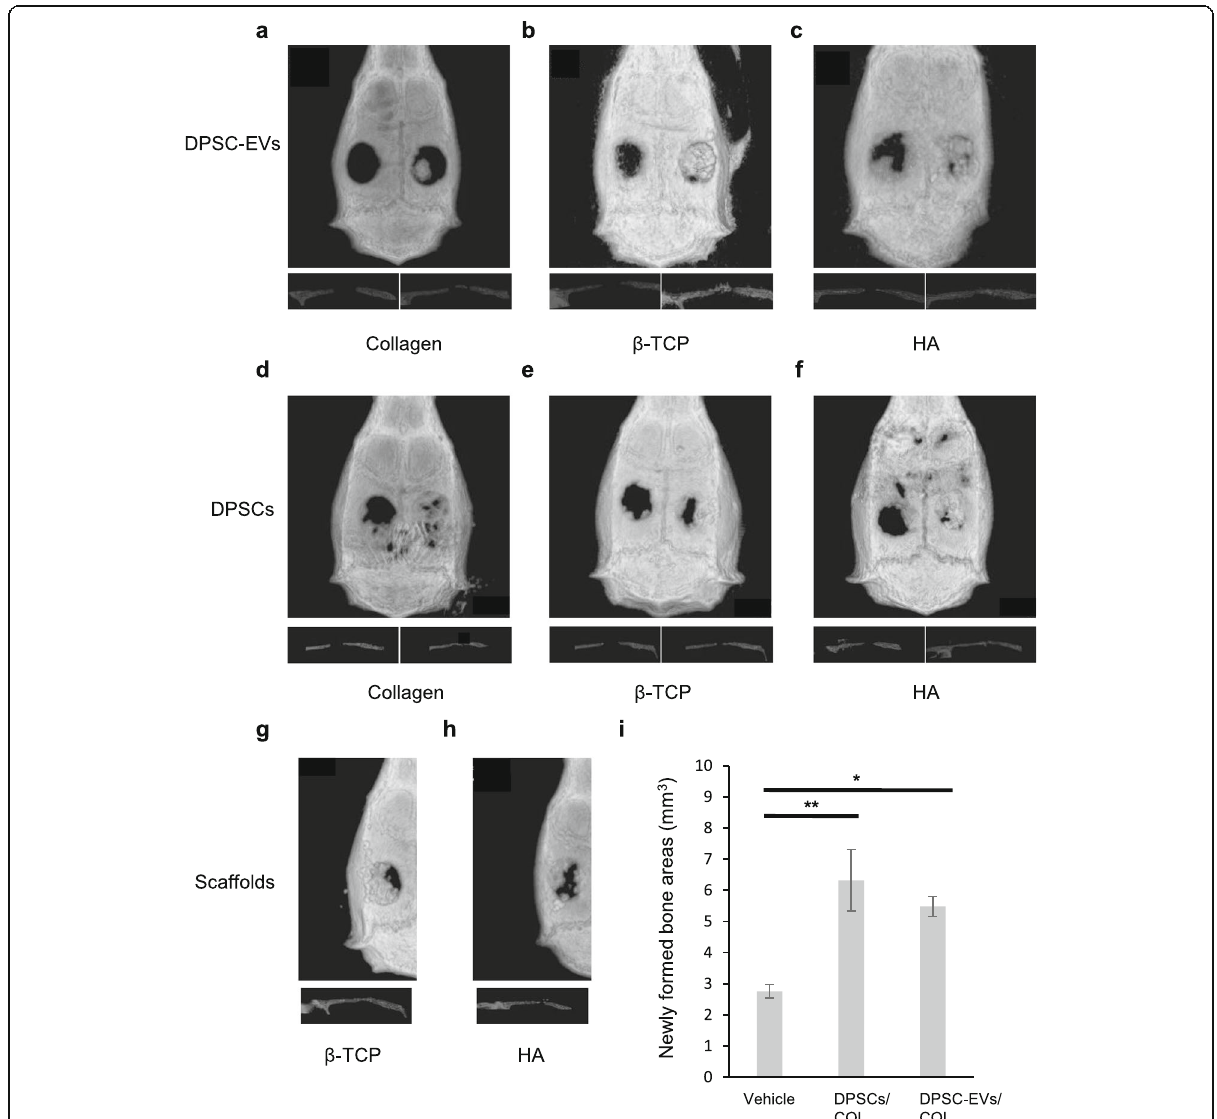
Fig. 3 Micro-CT analysis of calvarial defects 4 weeks after the procedure. Administration of DPSC-EVs with COL ( a ), β -TCP ( b ), and HA ( c ). Transplantation of DPSCs with COL ( d ), β -TCP ( e ), and HA ( f ). Filling of β -TCP ( g ) and HA ( h ). The upper image is a horizontal section. The lower images are left and right sagittal sections. i Volume of newly formed bone areas was measured by 3D images. Results are expressed as means ± SEM ( n =